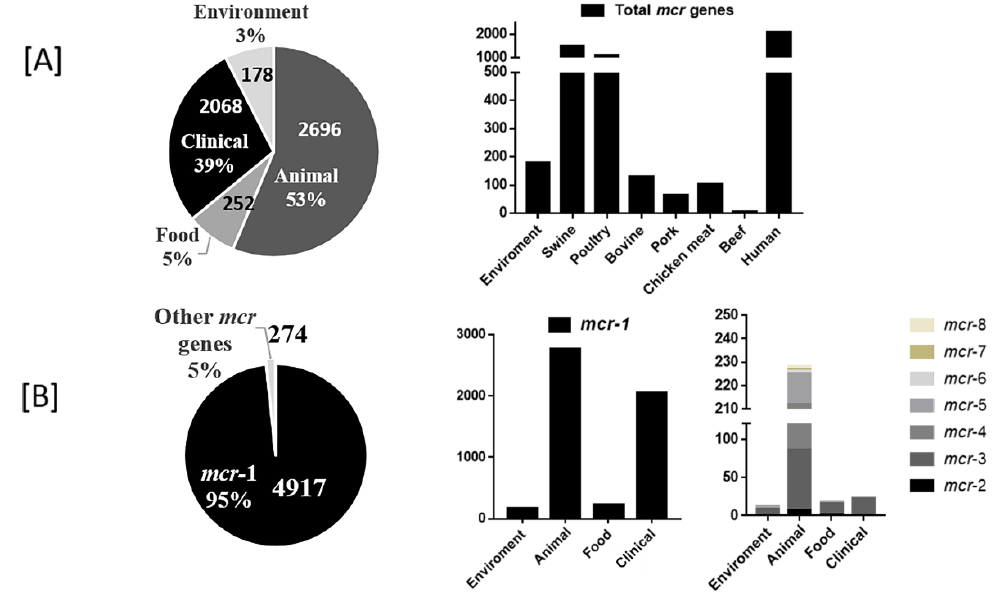
Figure 4. Frequency and distribution of mcr genes according to hosts and types. Hosts harboring mcr genes ( A ), mcr types ( B ).